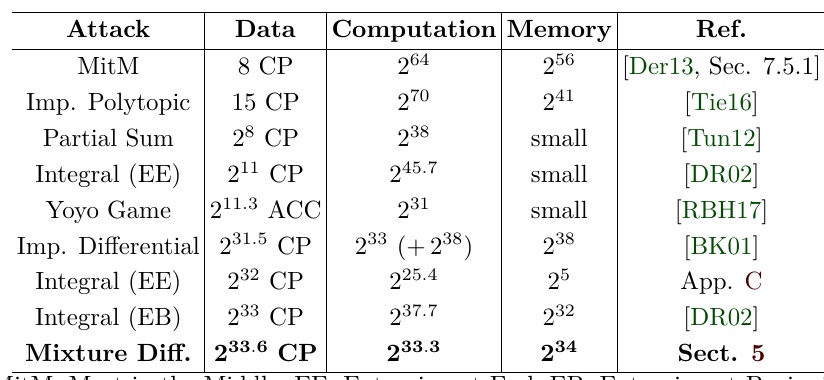
Table 2: Comparison of Attacks on 5-round AES-128. Data complexity is measured in number of required chosen plaintexts/ciphertexts (CP/CC) and/or adaptive chosen plaintexts/ciphertexts (ACP/ACC). Time complexity is measured in round-reduced AES encryption equivalents (E) - the number in the brackets denotes the precomputation cost (if not negligible). Memory complexity is measured in texts (16 bytes). Attack presented in this paper is in